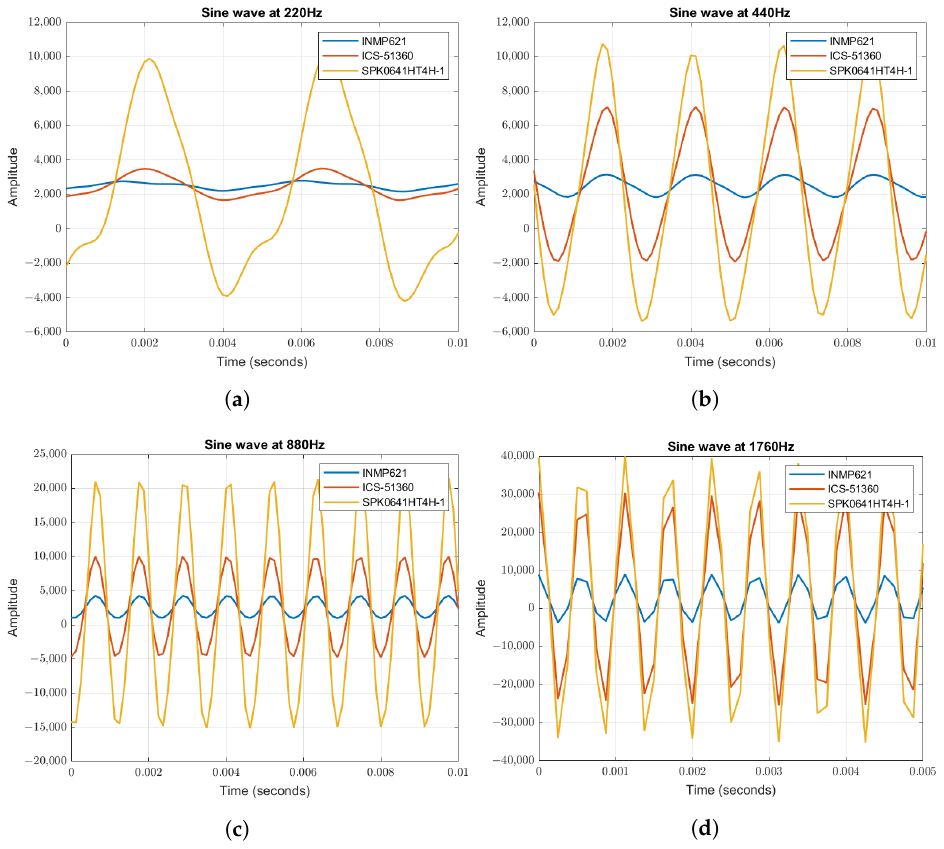
Figure 9. Data acquisition by the three types of microphones at different frequencies. ( a ) Sine wave at 220 Hz. ( b ) Sine wave at 440 Hz. ( c ) Sine wave at 880 Hz. ( d ) Sine wave at 1760 Hz.